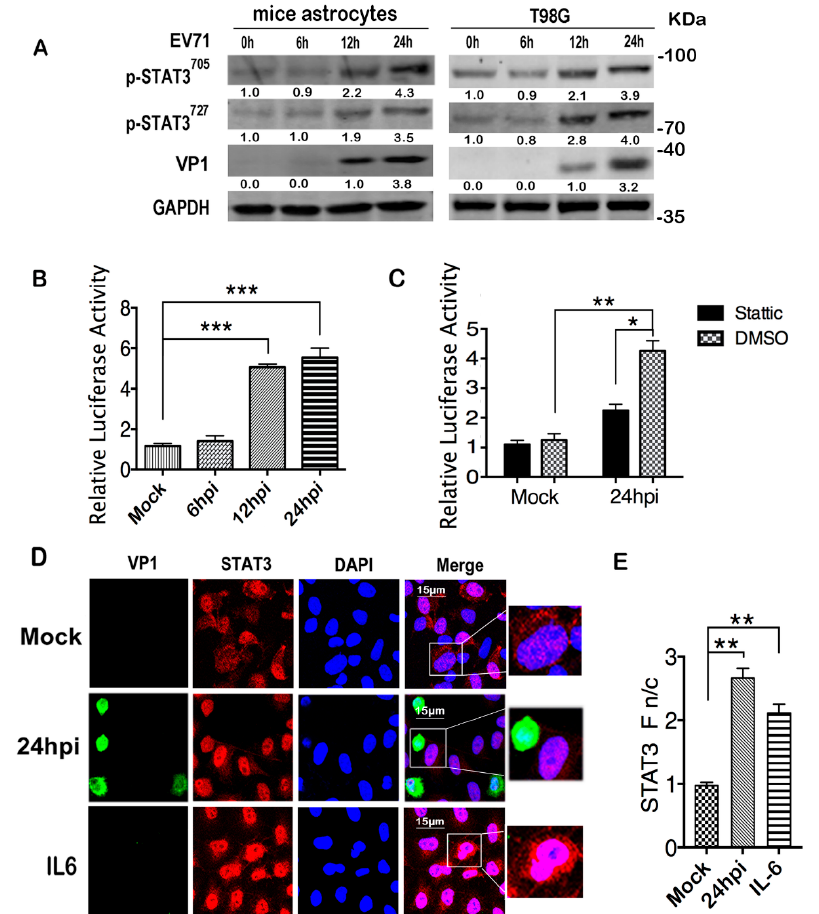
Figure 1. EV71 infection activated STAT3. ( A ) Phosphorylation levels of STAT3 at both Tyr705 and Ser727 sites were increased upon infection. Mice astrocytes and T98G cells were infected with EV71 at a multiplicity of infectivity (moi) of 10. For the mock infection group, culture medium the same as